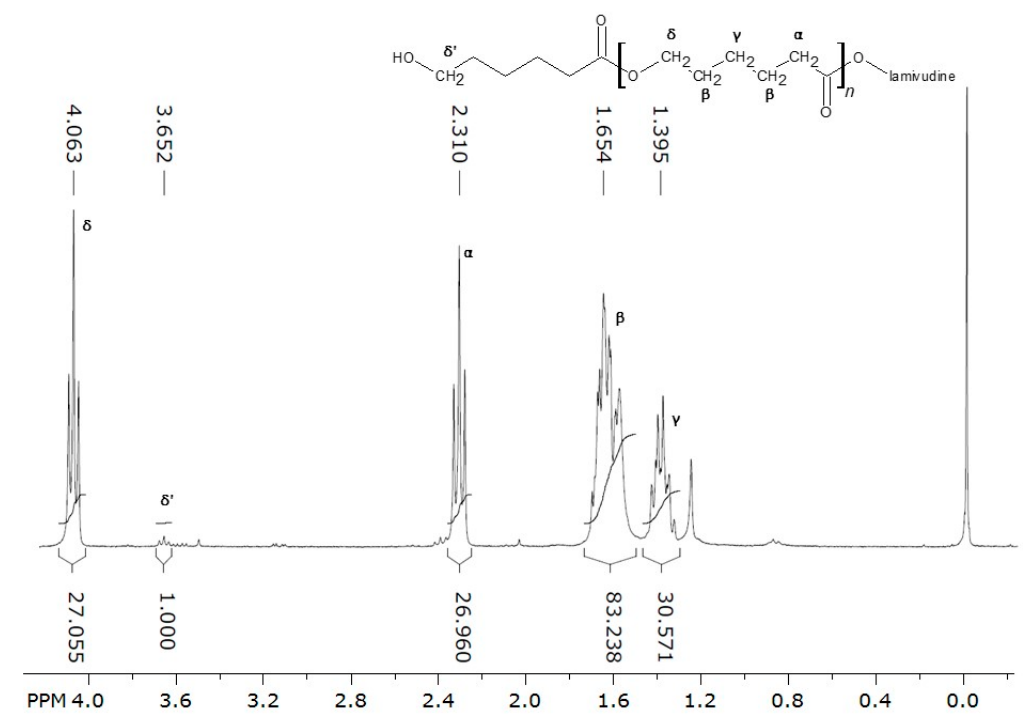
Figure 4. 1 H-NMR spectra of lamivudine-poly- ε -caprolactone conjugate with protons assigned to respective peaks.